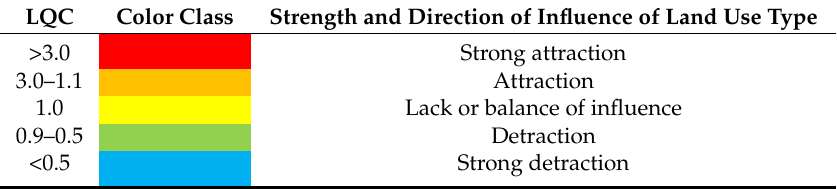
Table 4. Classification of the LQC based on the land use type influence and direction on